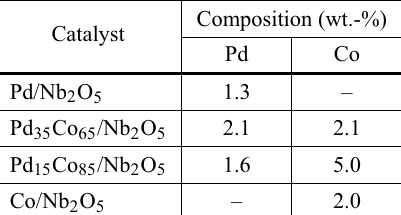
Composition of bimetallic catalysts (Noronha et al. 2000b).